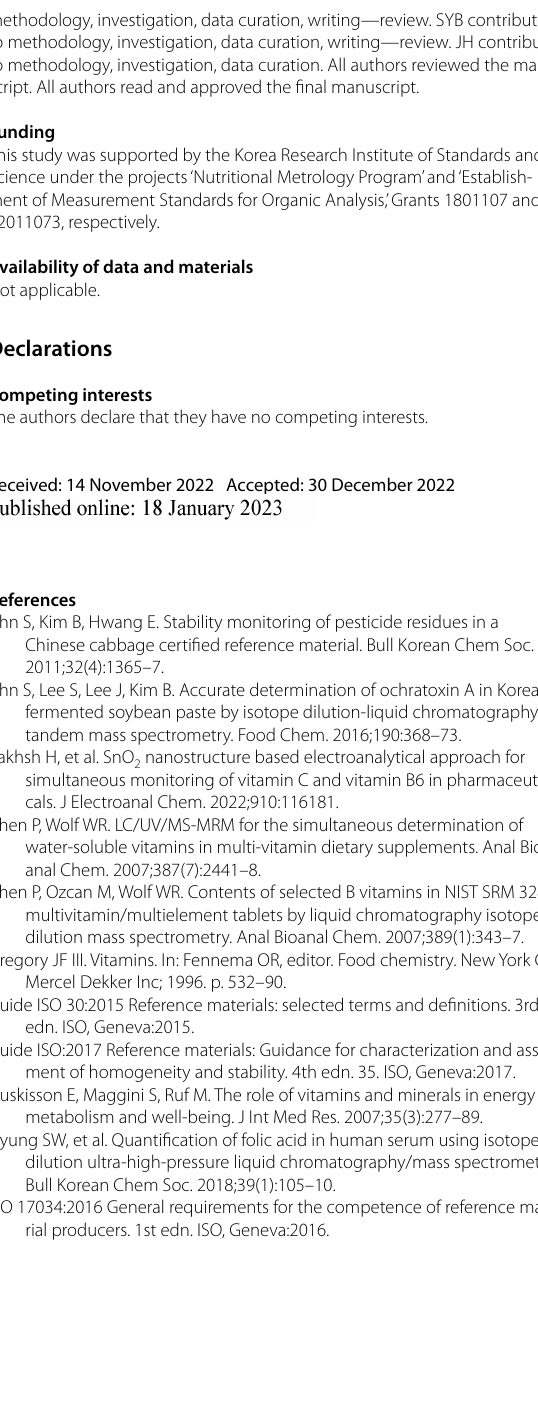
” is the expanded uncertainty of the property value at the 95% level of confidence ( k